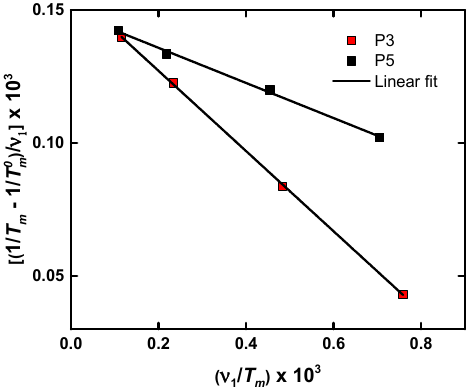
Figure 8. Graph of [(1/ T m – 1/ T m0 )/ υ 1 ] × 10 3 as a function of ( υ 1 / T m ) × 10 3.